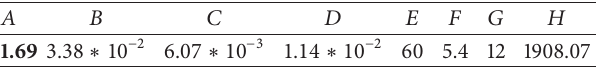
Table 8: The optimum polymerization conditions in accordance with single-factor